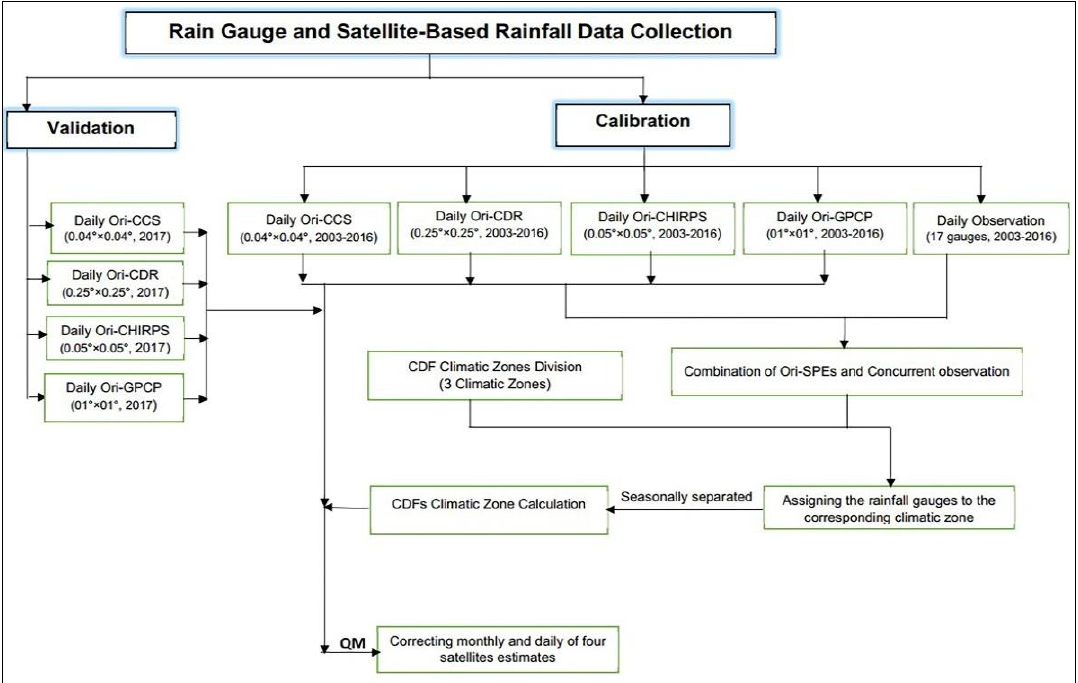
Figure 4. The bias correction flowchart.